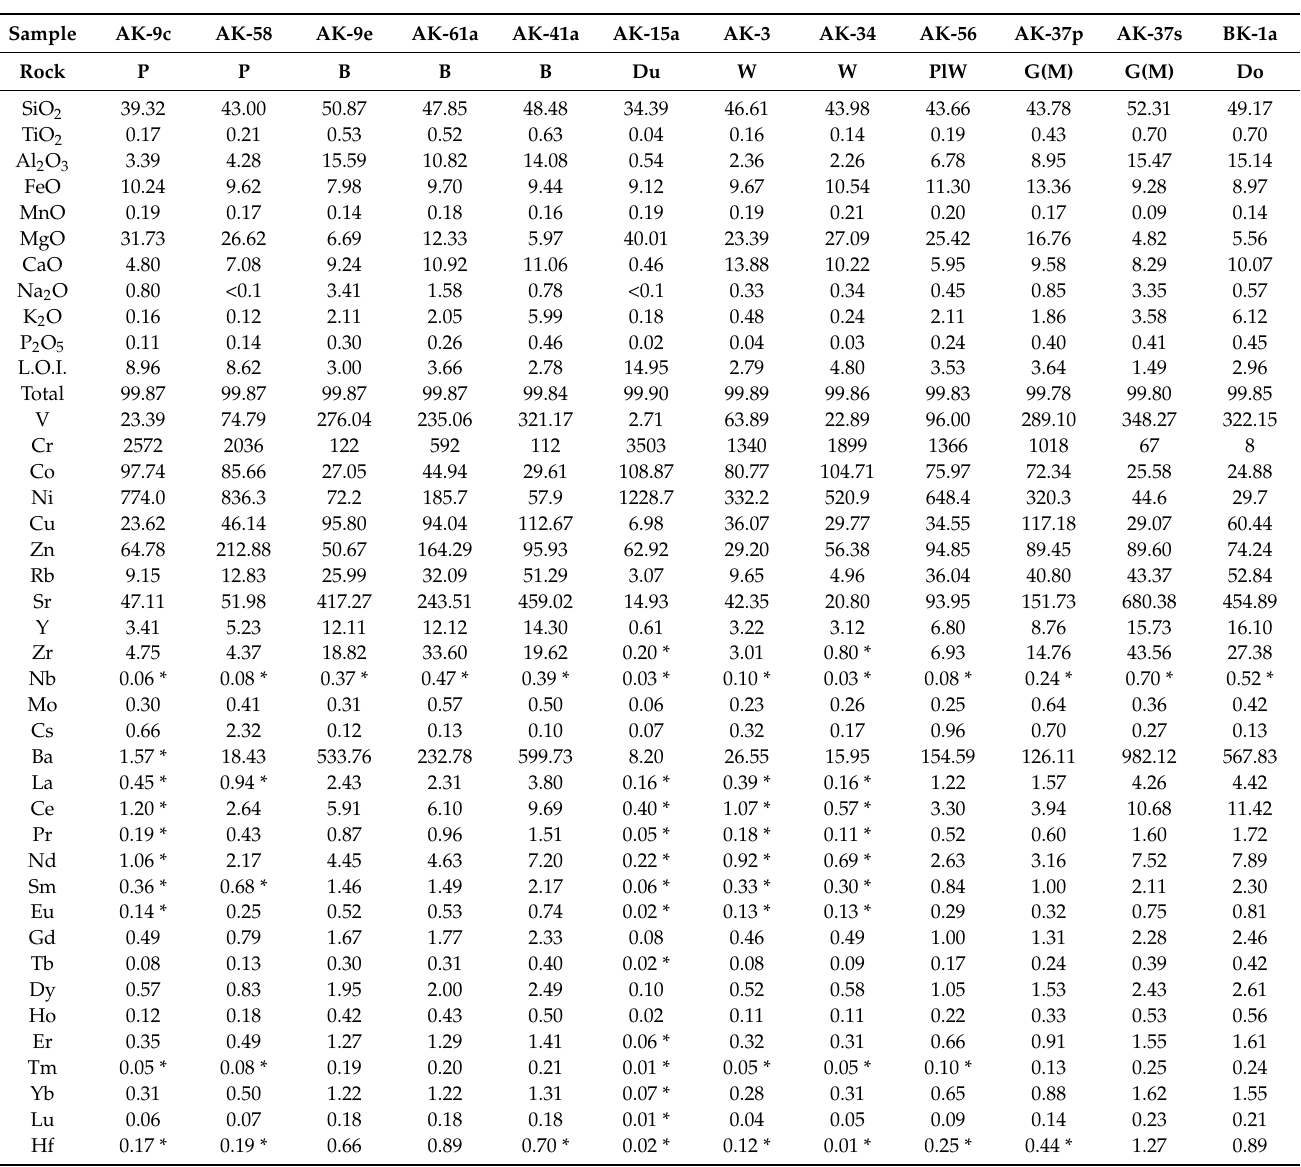
Table 2. Chemical composition of the selected